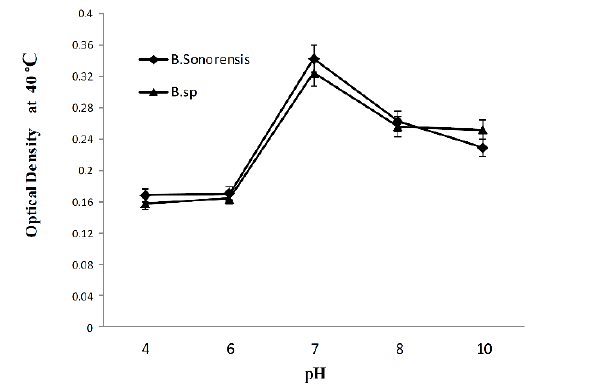
Fig. 4. Growth (optical density) of B . Sonorensis and B . sp. at 40 °C in different pHs (48